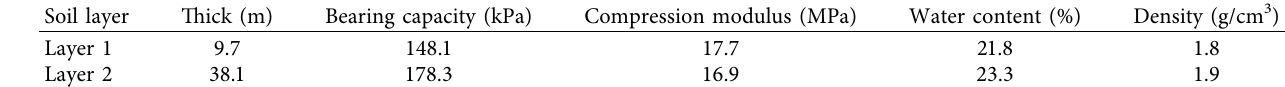
Table 2: Site soil characteristic parameters.